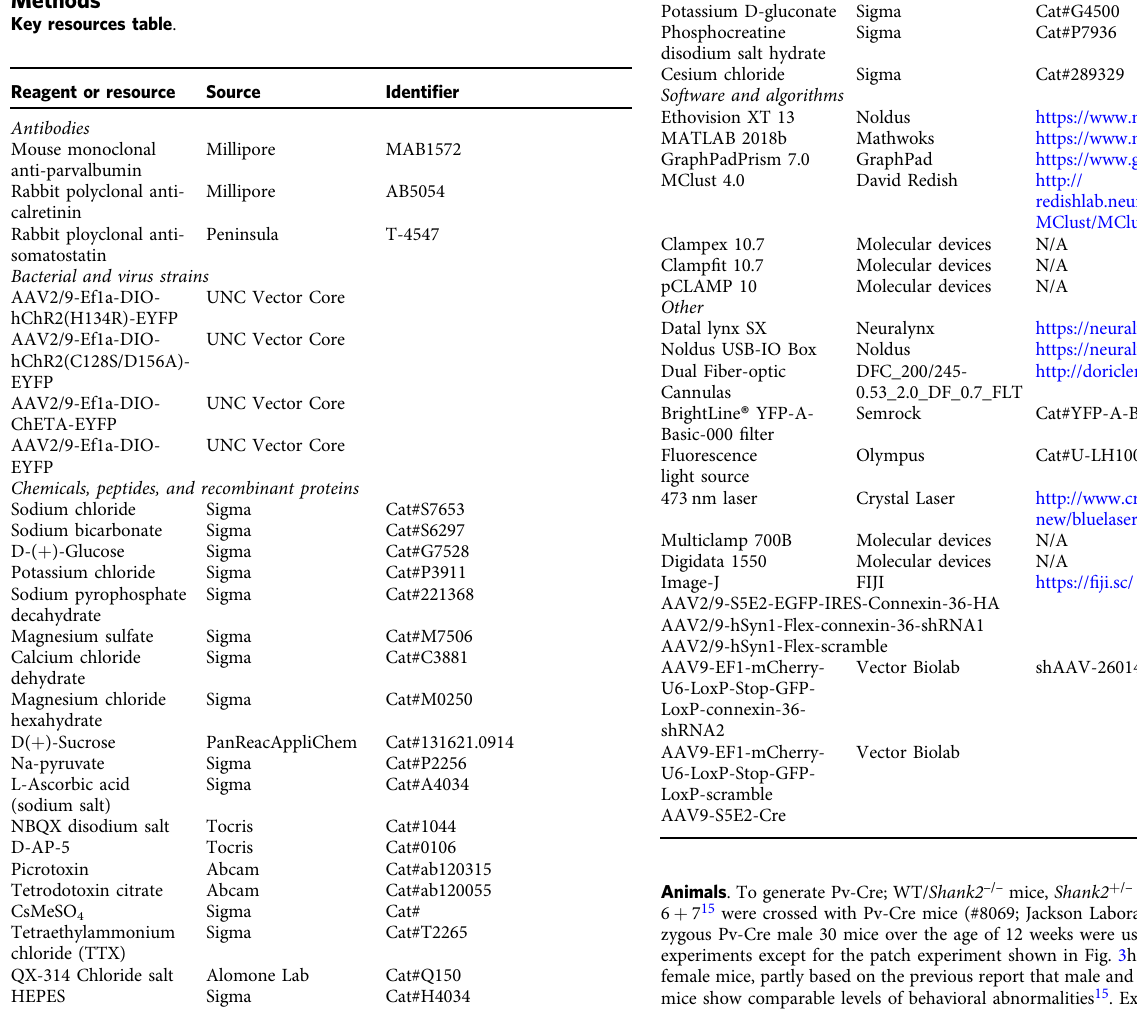
gap junctions in Pv neuronal bursts, (4) cooperative actions of NMDARs and gap junctions for Pv neuronal bursts, and (5) identi fi cation of gap junctions, additional to NMDARs, as a potential target for ASD therapy.